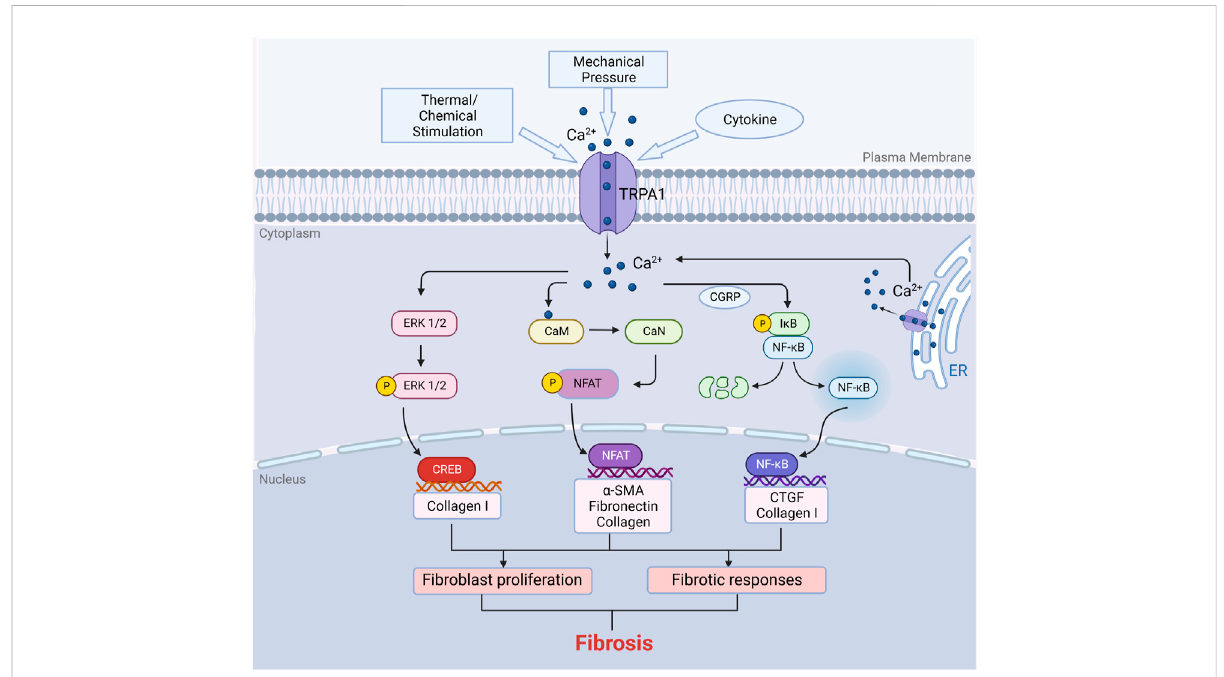
FIGURE 2 Function of TRPA1 in fi brosis. TRPA1 can be stimulated by temperature, chemicals, mechanical forces and cytokines such as IL-6, TNF- α and TGF- β . Activation of TRPA1 protein induces calcium in fl ux in fi broblasts. Calcium in fl ux activates several signaling pathways. The increase in calcium in fl uxin fi broblastsleadstothebindingofcalmodulintocalciumions,whichfurtheractivatescalcineurin.Calcineurininducesthedephosphorylation of NFAT in the cytoplasm, and then the dephosphorylated NFAT enters the nucleus to regulate gene expression, resulting in cell proliferation andimmuneresponses.Similarly,theincreaseinintracellular calciumcanalso activate theERK/CREBand NF- κ Bsignaling pathwaysto promotecell proliferation. Fibroblast proliferation consequently produces ECM, which results in fi brosis (Created with